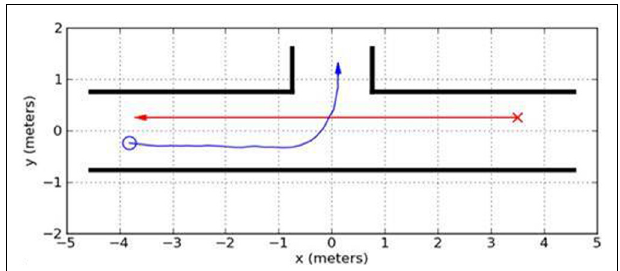
FIGURE 1 | Illustrative layout of the experimental space. Participant starting point is denoted by the red “X” and the robot starting point is denoted by the blue “O.” Idealized paths to the trial end points are denoted for the participant and the robot by the red and blue lines, respectively.